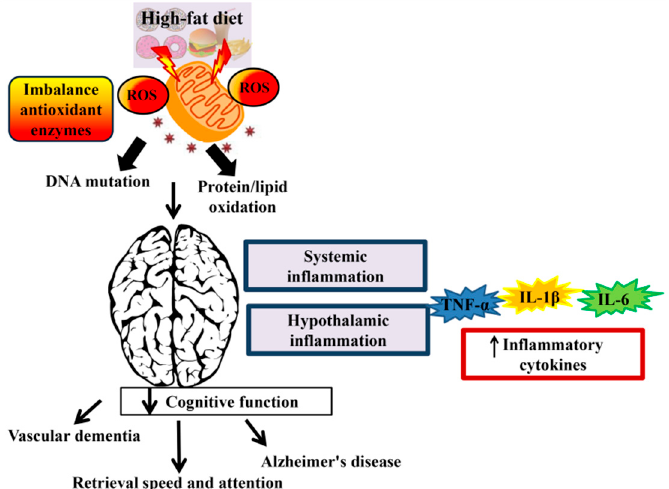
Figure 1. The effect of a high-fat diet (HFD) on cognitive function. Consumption of HFD induces reactive oxygen species (ROS). Accumulation of ROS leads to DNA mutation and protein/lipid oxidation and subsequently reduced the mitochondrial function. Overproduction of reactive species that occur in the mitochondrial DNA can lead to neurodegenerative disease and brain dysfunction. Systemic inflammation and hypothalamic inflammation promotes cognitive decline via secretion of inflammatory cytokines such as tumor necrosis factor alpha (TNF- α ), interleukin-1 beta (IL-1 β ), and interleukin-6 (IL-6).